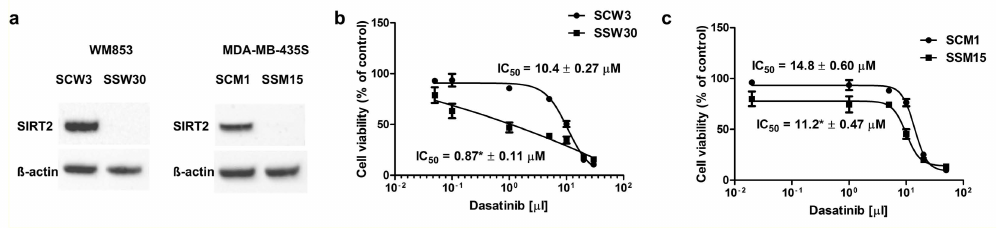
Figure 1. Cellular WM853 and MDA-MB-435S clone characteristics. ( a ) SIRT2 expression in SCW3 and SSW30 clones of WM853 cells and SCM1 and SSM15 clones of MDA-MB-435S as evidenced by Western blotting. ( b ) The cytotoxic e ff ects of dasatinib treatment (48 h) on melanoma SCW3 and SSW30 clones of the WM853 cell line, as evidenced using the neutral red assay, mean ± SD, ( n = 3, independent experiments) ( c ) The cytotoxic e ff ects of dasatinib treatment (48 h) on melanoma SCM1 and SSM15 clones of the MDA-MB-435S cell line, as evidenced using the neutral red assay, mean ± SD, ( n = 3, independent